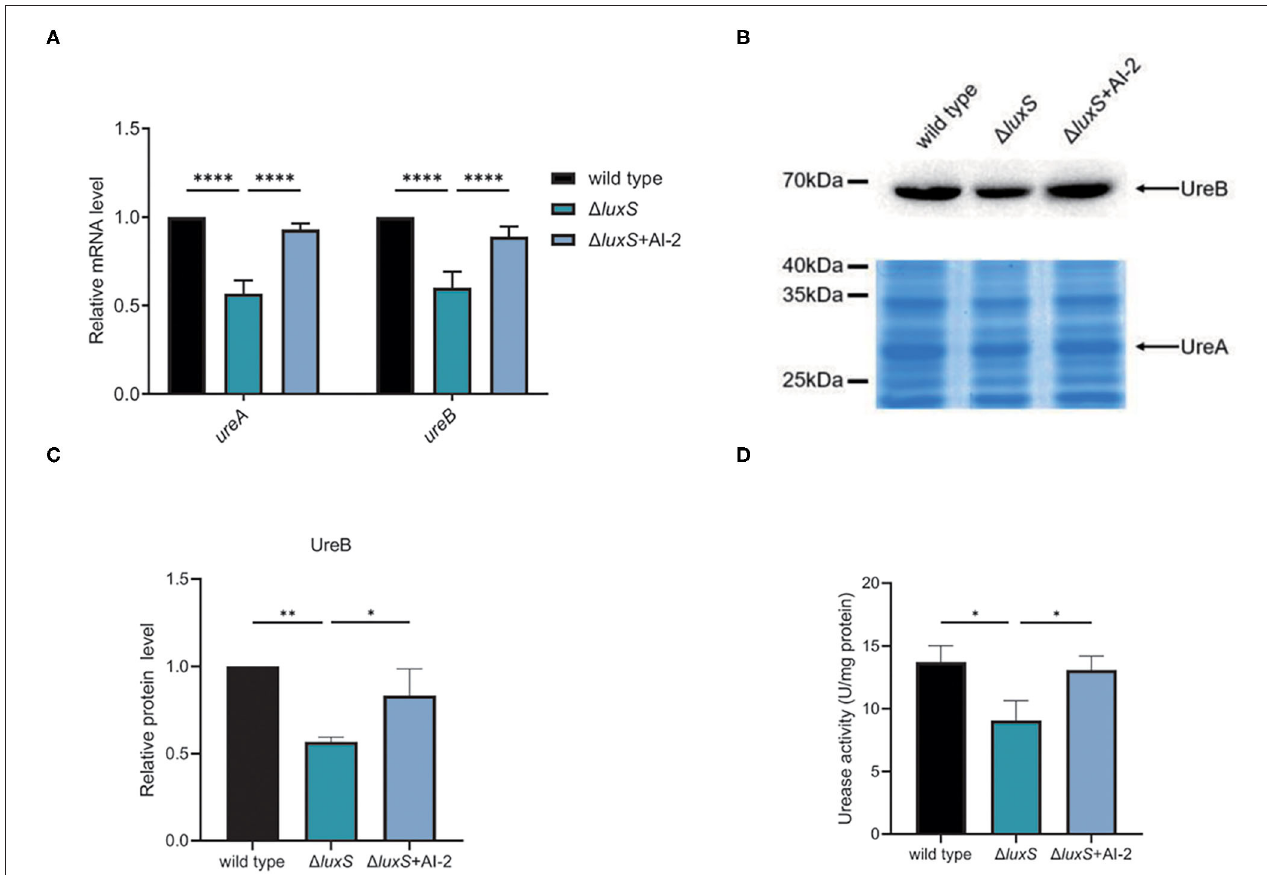
FIGURE 2 | AI-2 regulated the expression of urease. (A) Transcriptional levels of UreA and UreB regulated by AI-2, quantified by qPCR. Relative mRNA levels represent mRNA levels of UreA and UreB in the mutant strains normalized to those in the wild type strain. (B) Protein levels of UreA and UreB regulated by AI-2. Expression of UreB was determined by western blotting, with the arrow indicating protein bands of UreB. Expression of UreA were detected by SDS-PAGE followed by staining with Coomassie brilliant blue, with the arrow indicating protein bands of UreA. (C) Densitometric analysis of UreB protein bands. Total protein bands stained with Coomassie brilliant blue were used as loading control. (D) Determination of urease activity in cell lysates. Values are shown as averages of three biological independent experiments and bars represent standard deviations. **** P < 0.0001, ** P < 0.01, * P <